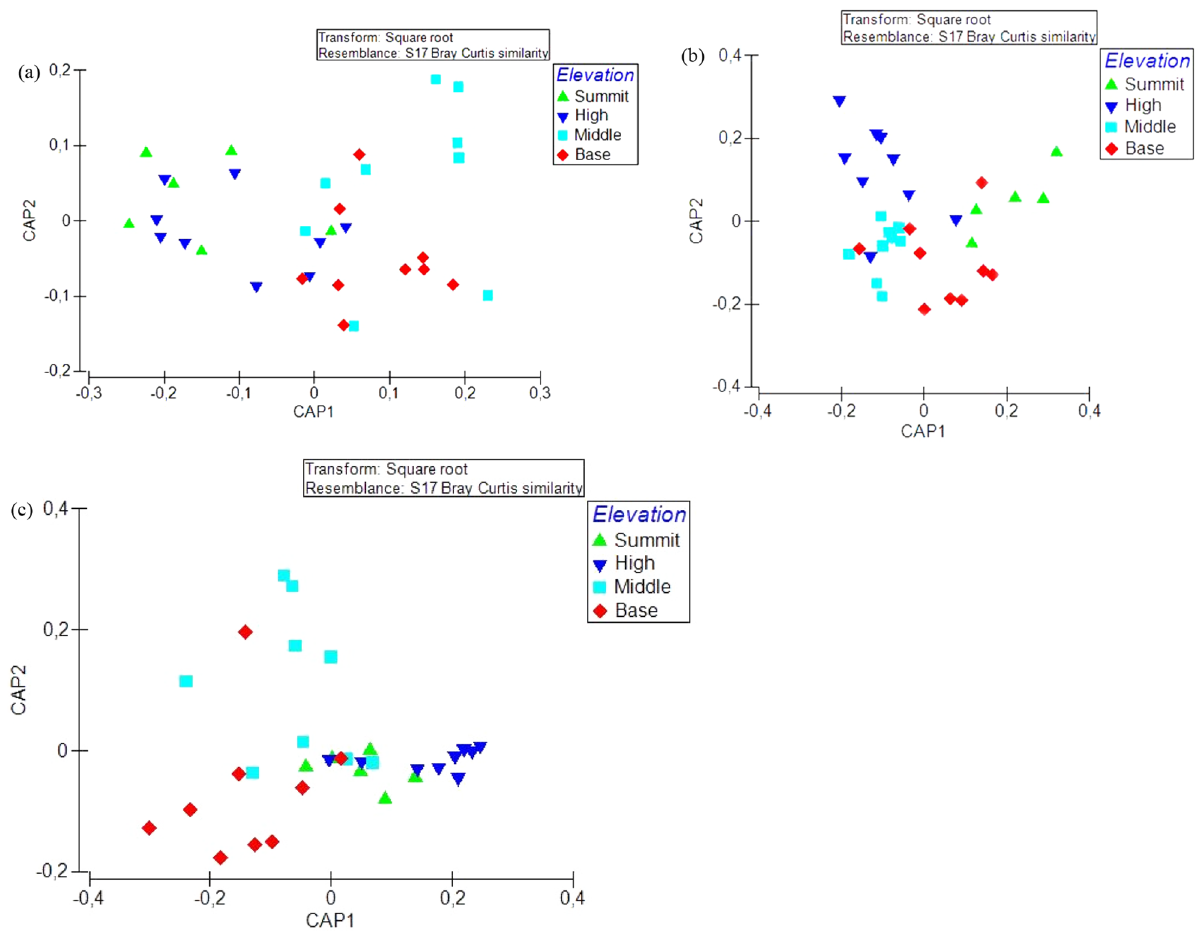
Figure 7. Canonical analysis of principal coordinates, showing differences in species composition of ( a ) bees, ( b ) beetles, and ( c ) wasps across elevation zones. CAP plot was computed using Bray-Curtis similarity index obtained from the square-root transformation of abundance